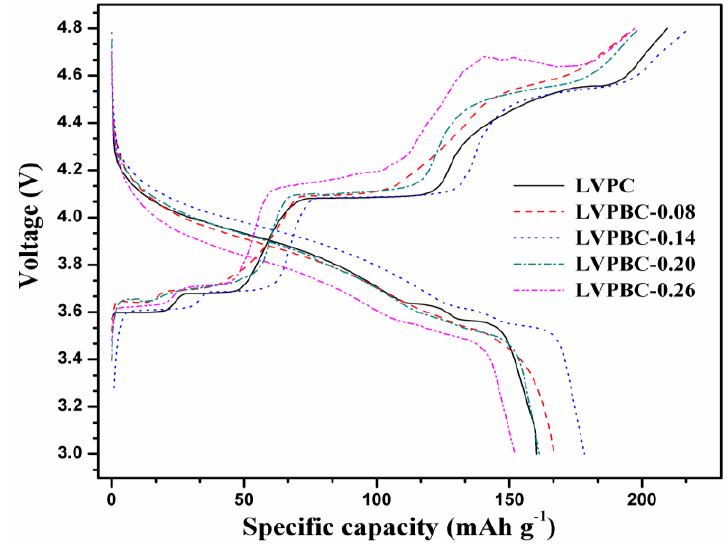
Figure 3. Initial charge/discharge curves of the LVPBC and pristine LVPC composites.